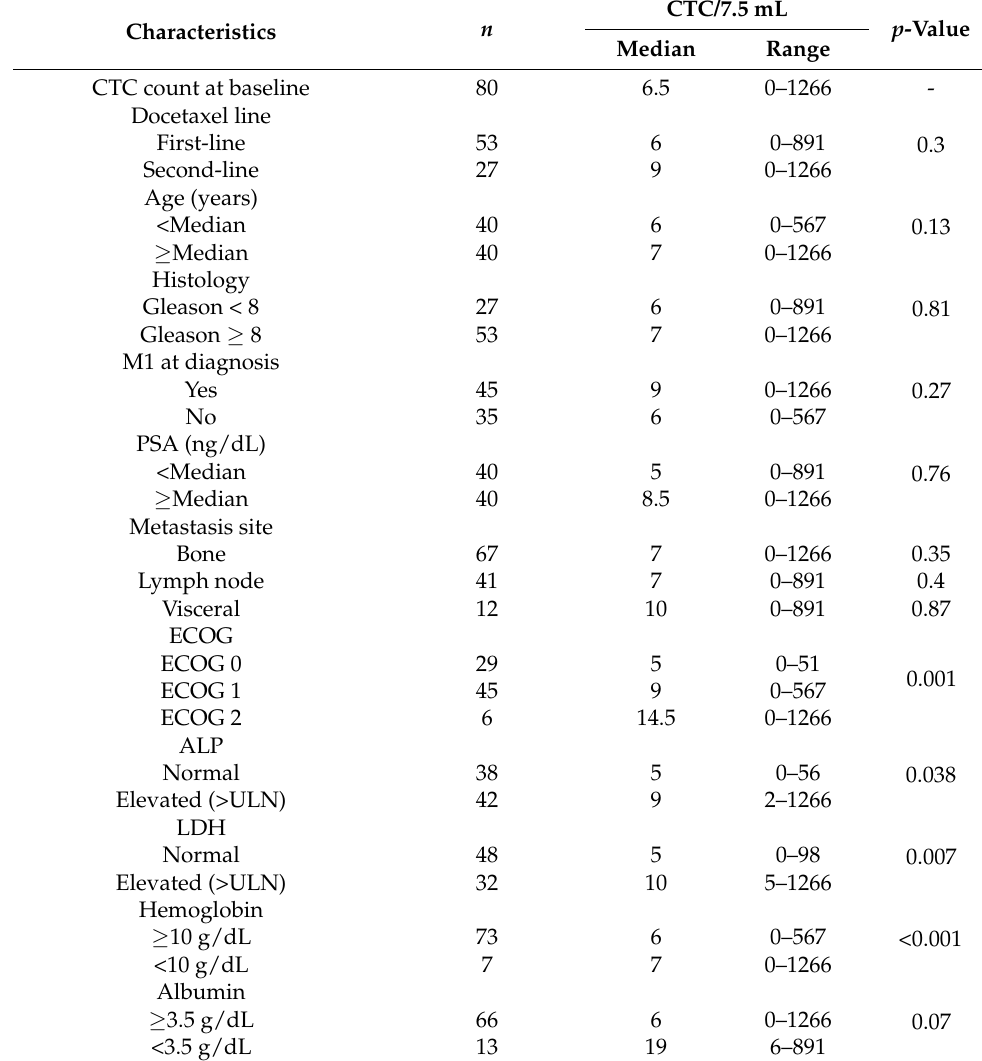
Table 2. Associations between CTC count and baseline characteristics of